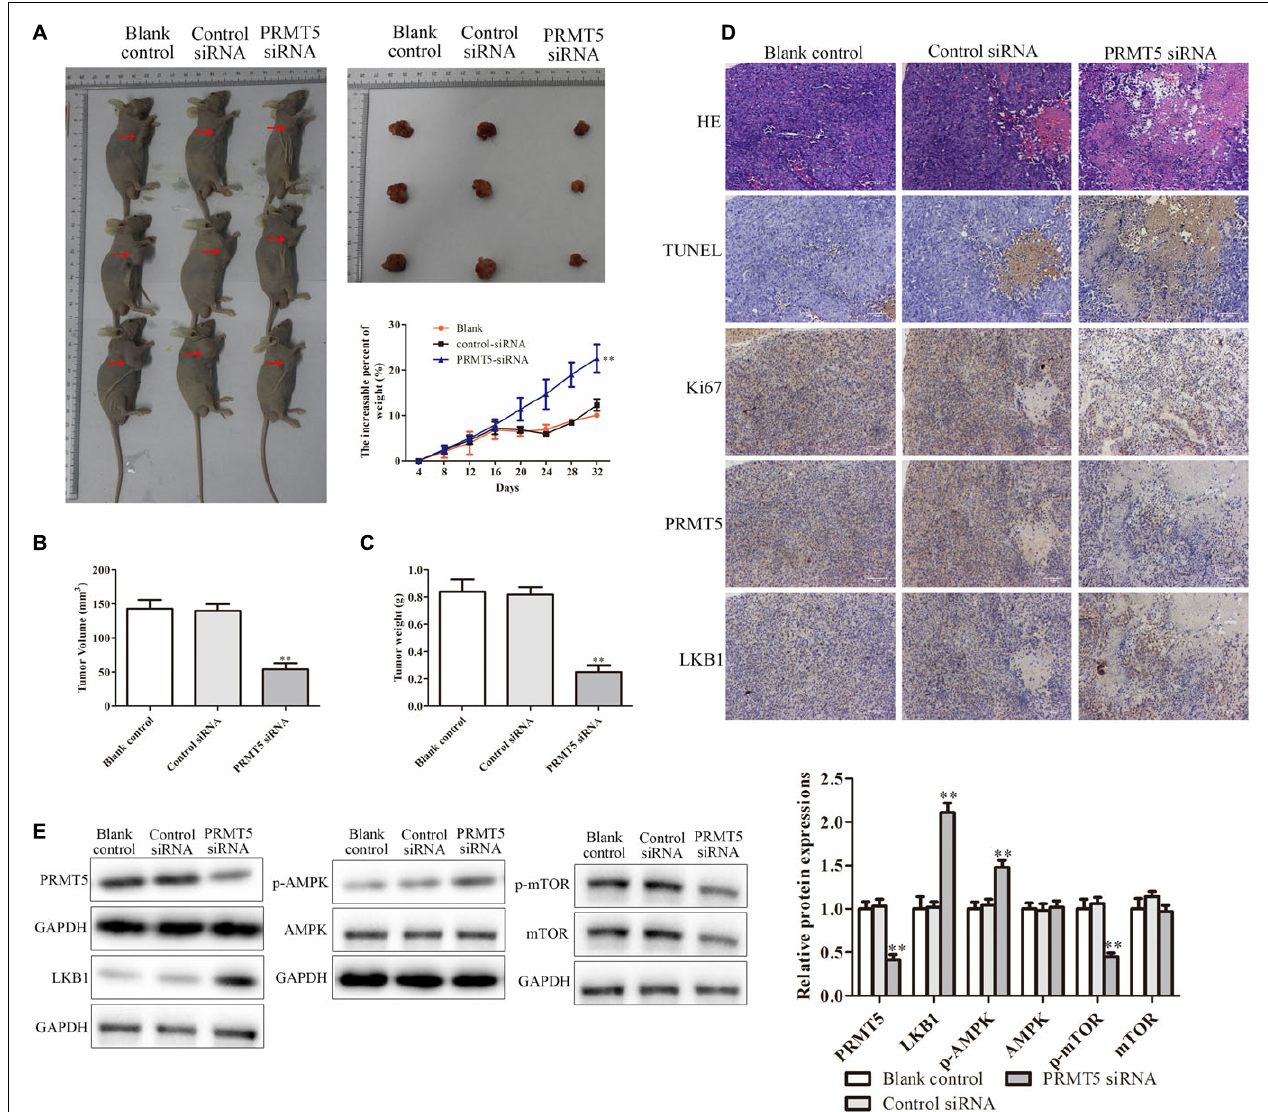
FIGURE 8 | PRMT5 promoted the tumor growth in vivo via LKB1/AMPK/mTOR signaling pathway. The transfected KYSE150 cells were injected into the axilla of the nude mice. (A) Mice, tumors, and mouse weight are shown. (B,C) Tumor volume and weight were measured in different groups. (D) Immunohistochemistry indicated the expressions of Ki-67 and PRMT5 were lower in mice injected with ESCC cells transfected with siRNA PRMT5, while the expressions of TUNEL and LKB1 were higher. The photographs were taken at the magnification of × 200. (E) The expression levels of PRMT5, LKB1, AMPK, p-AMPK, mTOR, and p-mTOR were analyzed in ECA109 and KYSE150 cells. GAPDH was used as a control. Bars indicate the mean ± SEM, * P < 0.05, ** P < 0.01 vs. control siRNA. PRMT5, protein arginine methyltransferase 5; LKB1, liver kinase B1; AMPK, adenosine monophosphate kinase; mTOR, mammalian target of rapamycin; ESCC, esophageal squamous cell